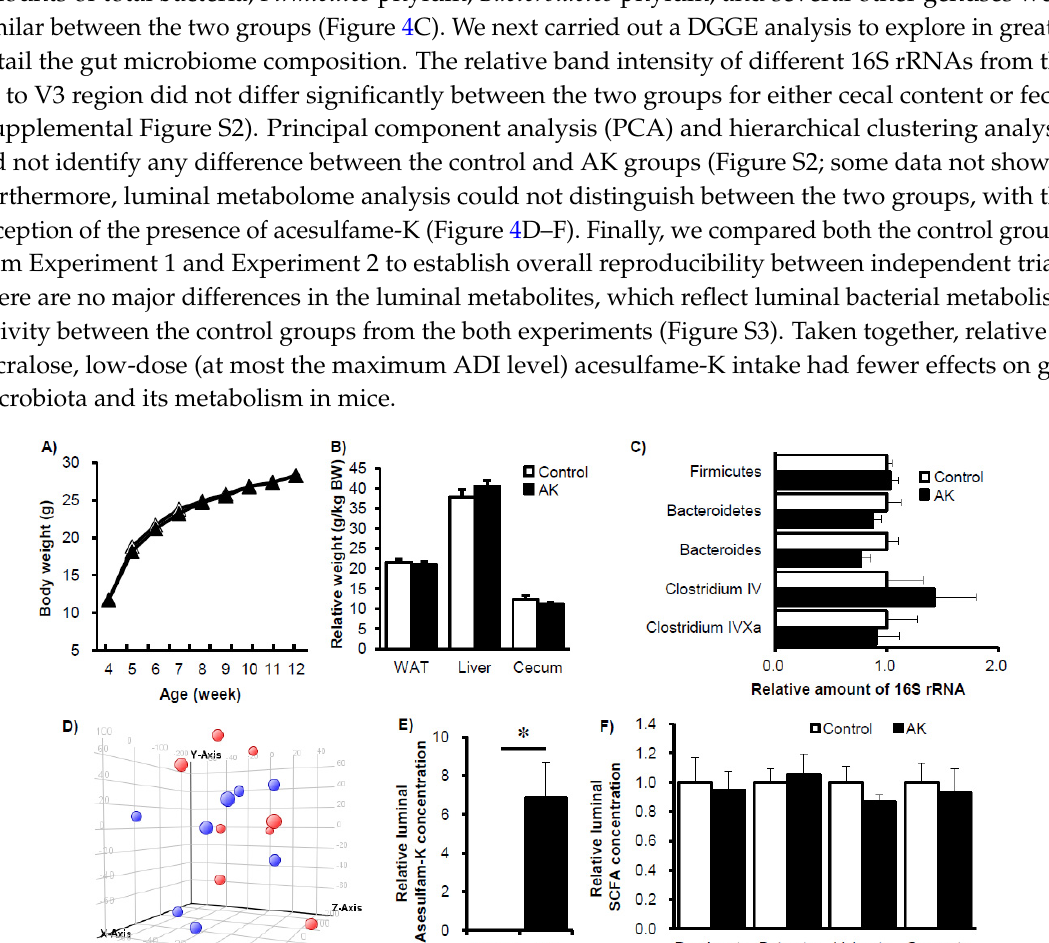
butyrate ( C ), and specific amino acids ( D ) in mice fed sucralose for 8 weeks. Data represent mean ±